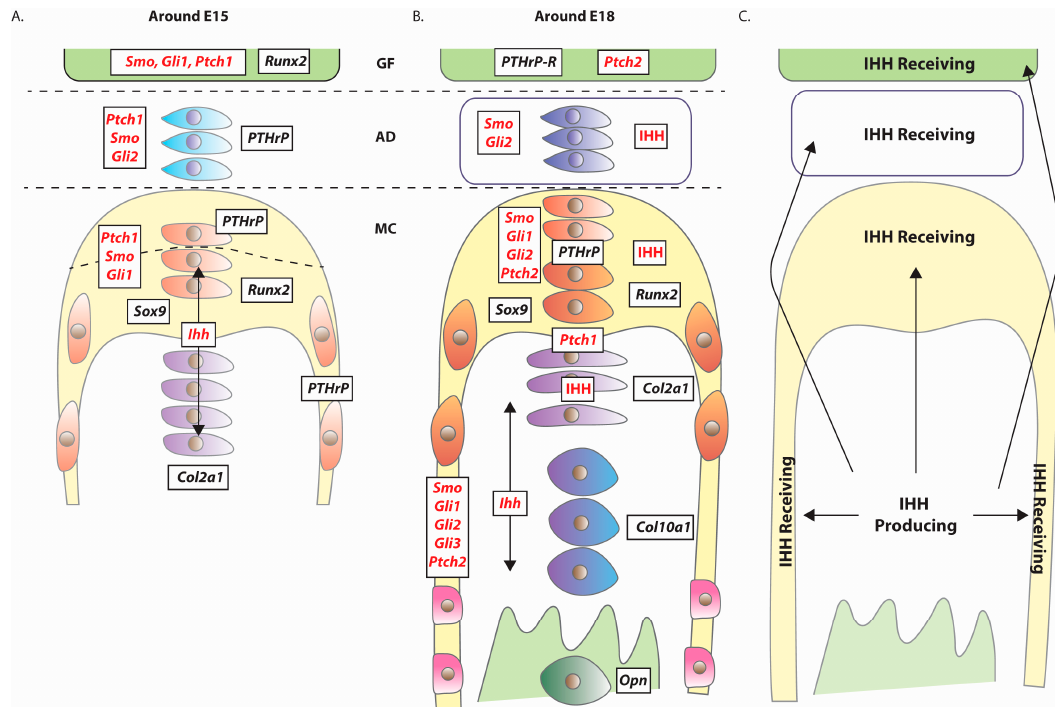
Figure 3. Hh signaling within the developing TMJ. Approximate representation of the murine expression patterns of various chondrogenic and osteogenic regulators (black text) including components of the Hh signalling pathway (red text) around ( A ) E15 and ( B ) E18. The bulk of supporting data is from in situ hybridisation studies of mRNA expression [17,32,34], with only IHH ligand protein expression established in E18 tissue [33]. Please note that IHH is an extracellular signalling molecule capable of long-range transport, meaning that IHH protein does not necessarily have to co-localise with those cells expressing Ihh (e.g., the detection of IHH protein in non- Ihh expressing fibrous cells and articular disc cells). Such observations support a role for intra- and inter-tissue IHH-mediated signalling. ( C ) A generalised overview of the regions initiating Hh signalling ( Ihh expressing), responding to and/or capable of being stimulated by IHH ligand. Figure adapted from Shibukawa et al. [32].